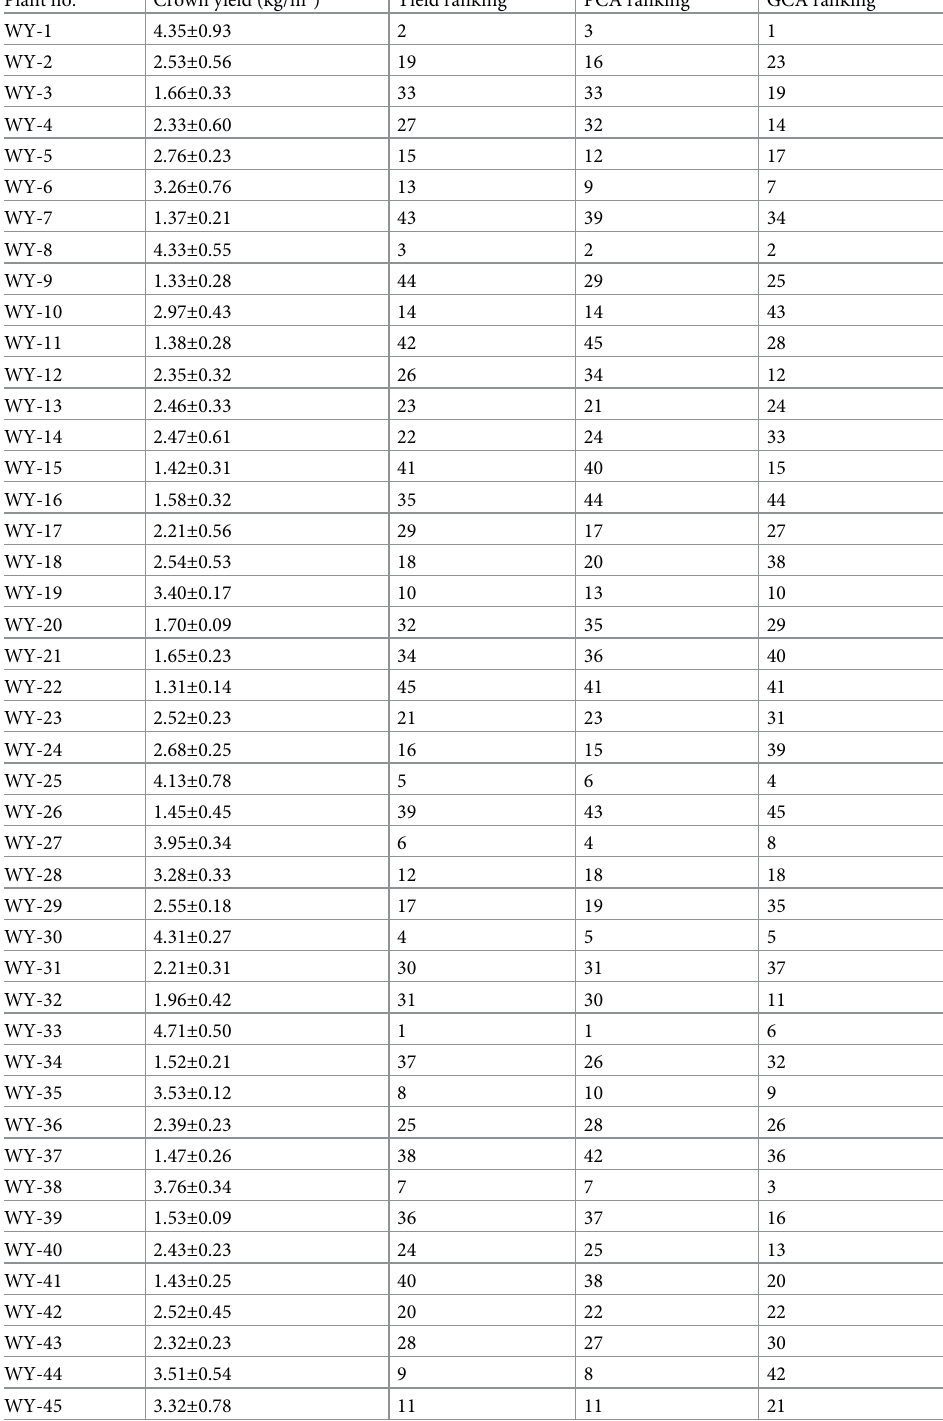
Table 6. Comparison between the rankings according to principal component analysis and gray correlation analy- sis and those in terms of five-year average crown yield. Plant